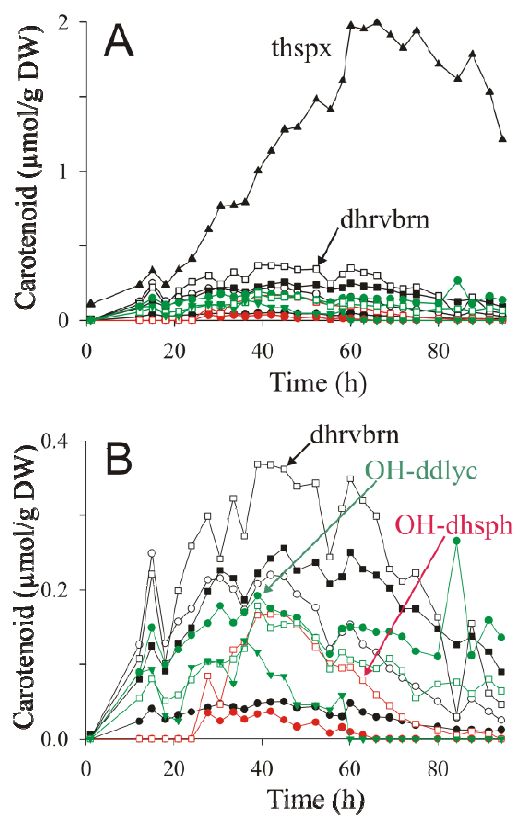
Figure 3. Primary data for dynamic changes of various carotenoid species. The figure shows LC-MS data from extracts of ST4 obtained at various time points of a semi-aerobic growth curve performed under an argon atmosphere. The data for all of the carotenoids determined are shown in ( A ). The same data, excluding thspx, have been plotted with an expanded scale ( B ) for clarity. Abbreviations: thspx ( ▲ ); 3,4-dihydrorhodovibrin (dhrvbn) ( □ ); rhodopin ( ○ ); 3,4-dihydroanhydrorhodovibrin ( ■ ); lycopene ( ● ); chloroxanthin ( ● ); 1 ′ -OH-3,4-dihydrospheroidene (OH-dhsph) ( □ ); 1 -OH-3,4-didehydrolycopene (OH-ddlyc) ( ●